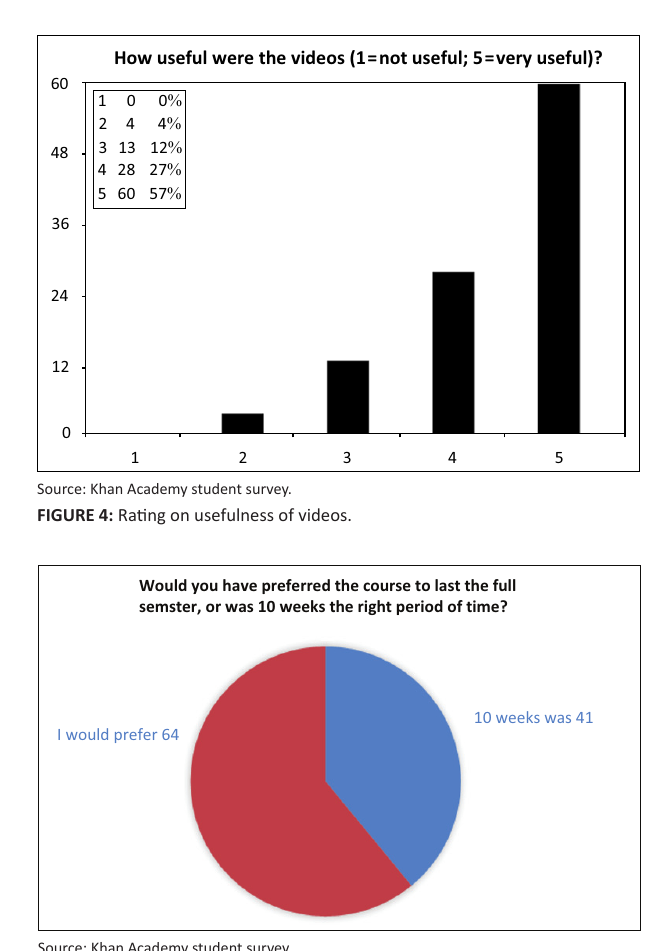
FIGURE 5: Duration of Khan Academy